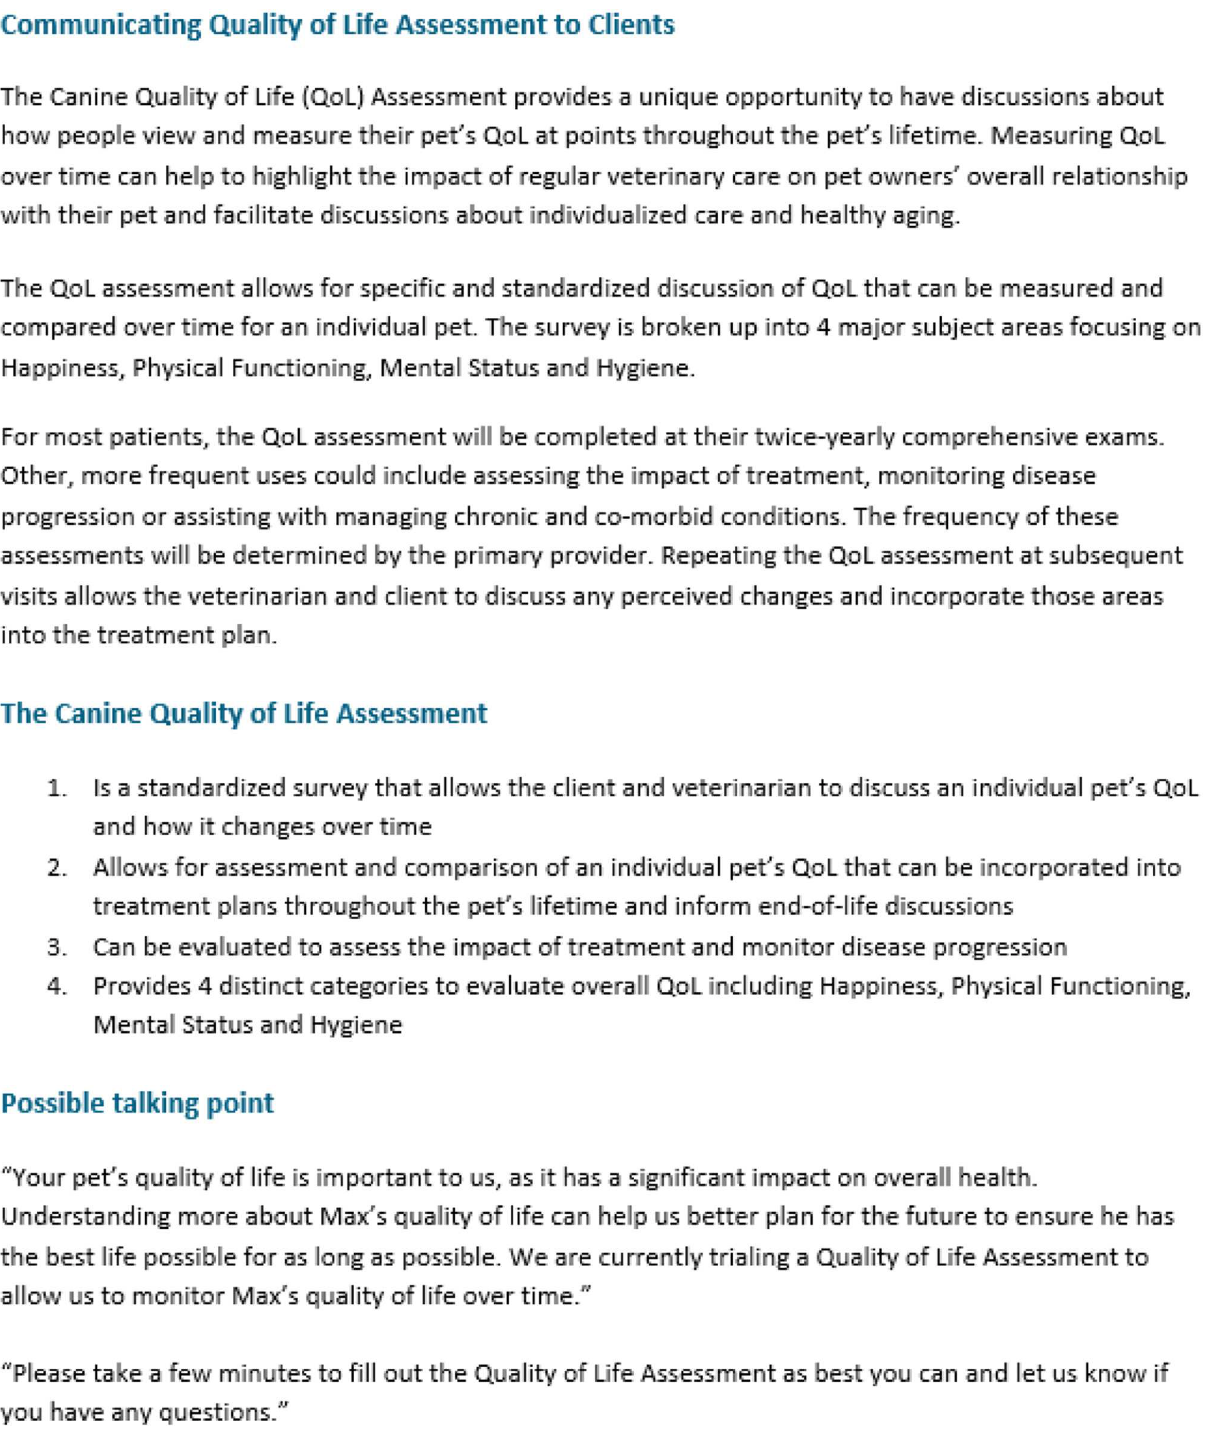
FIGURE 2 | One-page guidance document.